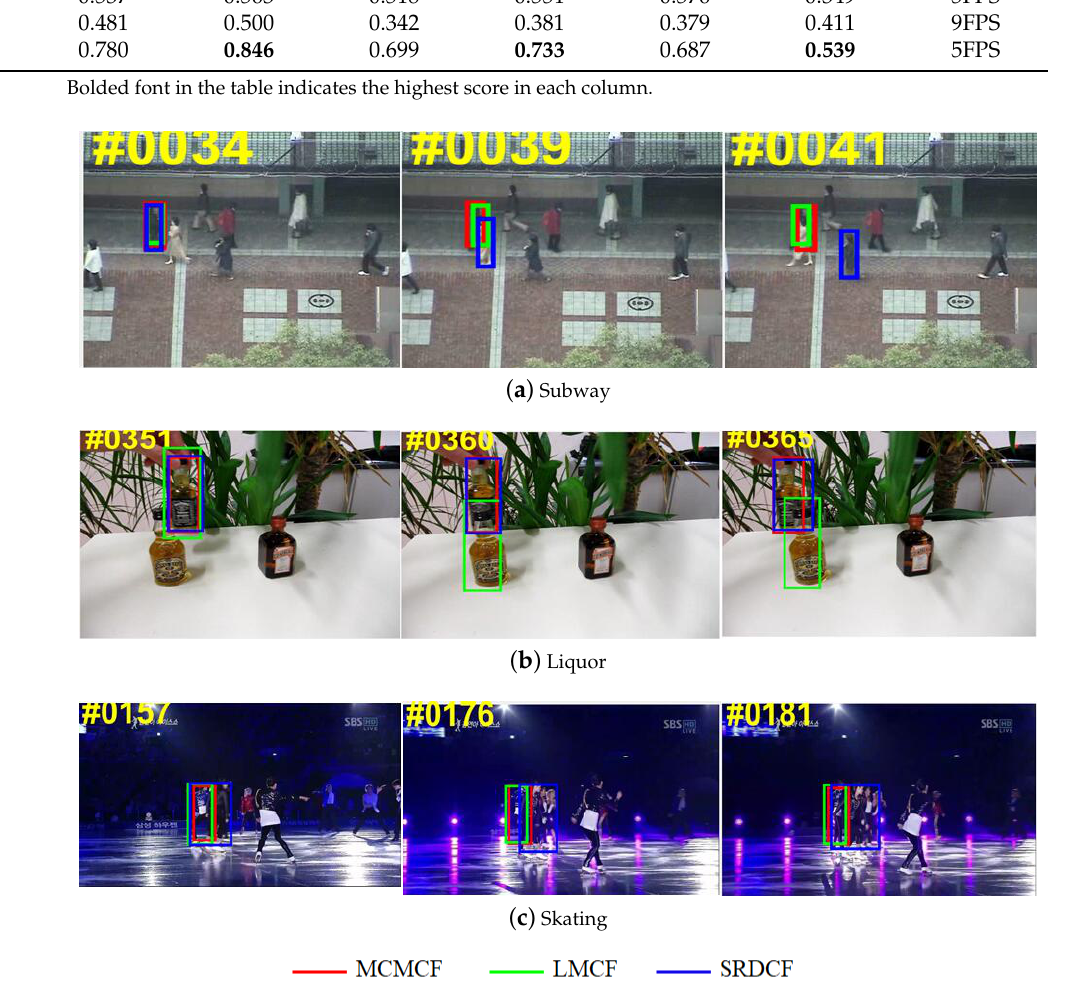
Figure 6. Results of different algorithms for some video sequences on the OTB100